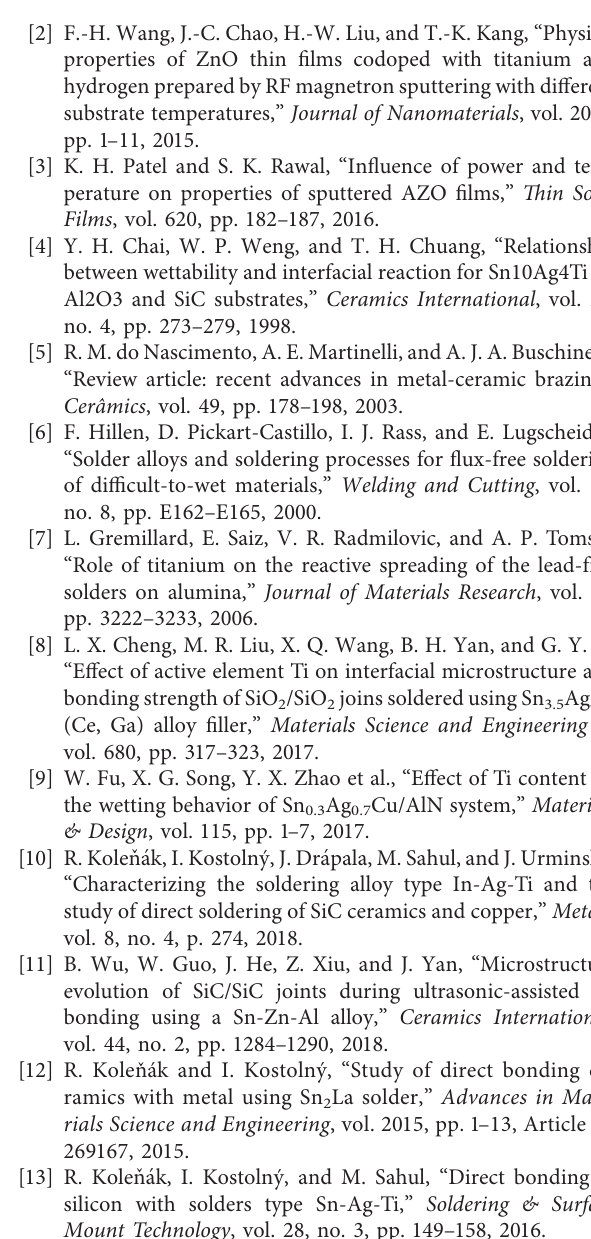
° C: (a) the Cu side; (b) the ZnO